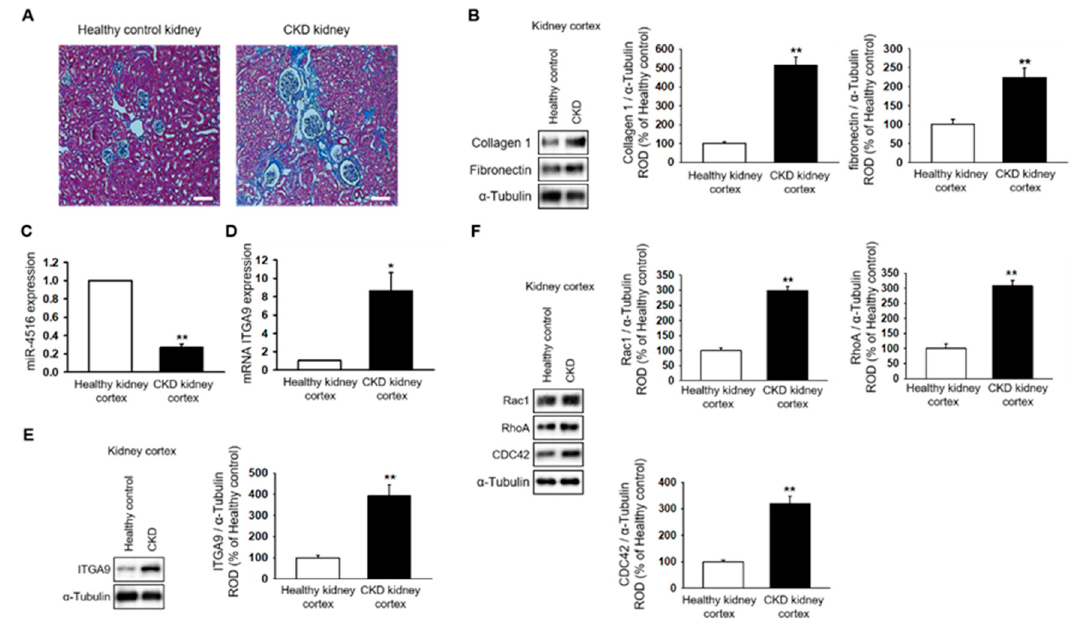
Figure 1. Expression of miR-4516 is downregulated in renal cortical fibrosis in a CKD mouse model. ( A ) In healthy mice ( n = 3) or CKD mice ( n = 3), hematoxylin and eosin (H&E) staining was performed on kidney sections (scale bar = 1000 μ m). ( B ) Western blot analysis for collagen type 1, and fibronectin in the kidney cortex of healthy mice and CKD mice ( n = 3). Protein expression was determined by densitometry relative to α -tubulin. The values represent mean ± SEM. ** p < 0.01 vs. healthy kidney cortex. ( C , D ) Expression of miR-4516 and ITGA9 was detected in the kidney cortex of healthy mice ( n = 3) or CKD mice ( n = 3) by quantitative real-time polymerase chain reaction (qPCR). The values represent mean ± SEM. * p < 0.05, ** p < 0.01 vs. healthy kidney cortex. ( E , F ) Western blot analysis for ITGA9, Rac1, RhoA, and CDC42 in the kidney cortex of healthy mice and CKD mice ( n = 3). Protein expression was determined by densitometry relative to α -tubulin. The values represent the mean ± SEM. ** p < 0.01 vs. healthy kidney cortex.